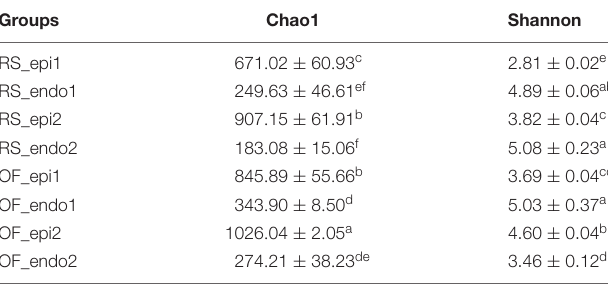
TABLE 3 | α diversity indices (Chao1 and Shannon) of the epiphytic and endophytic fungal community of “Hongyang” and “Cuiyu” kiwifruit grown under rain-shelter and open-field cultivation systems. Groups